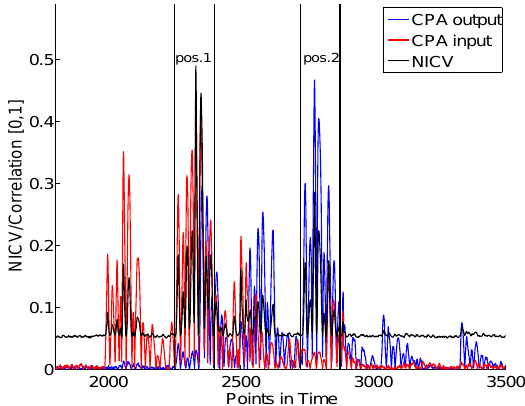
Figure 13: Profiling results on ARM, using CPA on the SBox input, CPA on the SBox input, and NICV